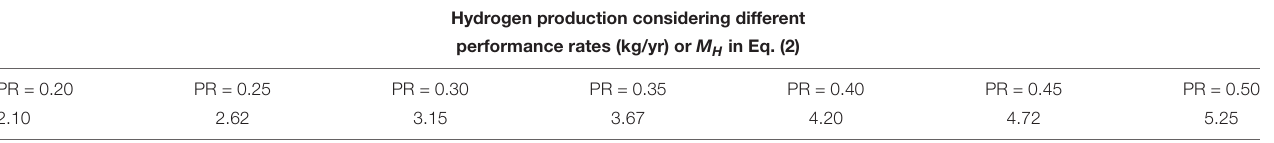
Hydrogen production considering different performance rates (kg/yr) or M H in Eq. (2)